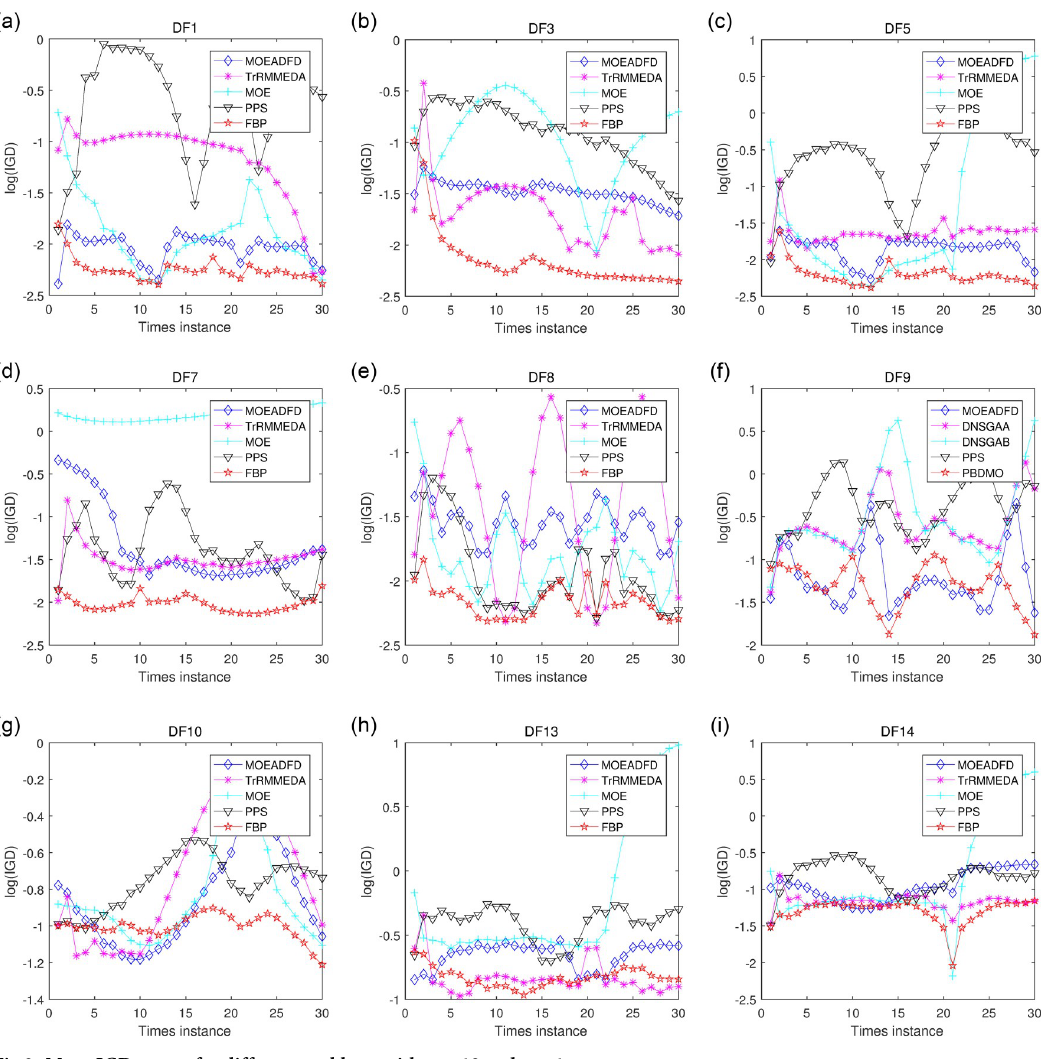
Fig 3. Mean IGD curves for different problems with n t = 10 and τ t =